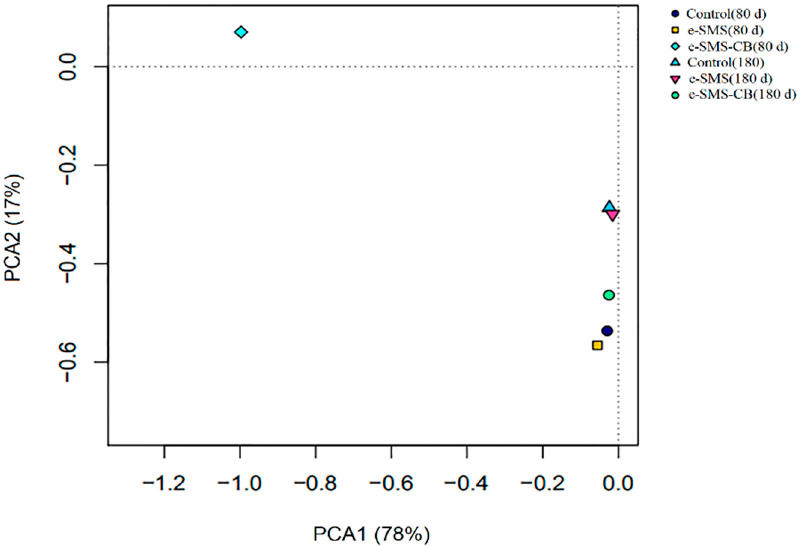
Figure 3. Principal component analysis (PCA) of all six samples based on microbial community composition. Control: real soil as control group; e-SMS: real soil + P. eryngiu -SMS; e-SMS-CB: real soil + P. eryngiu -SMS-CB.